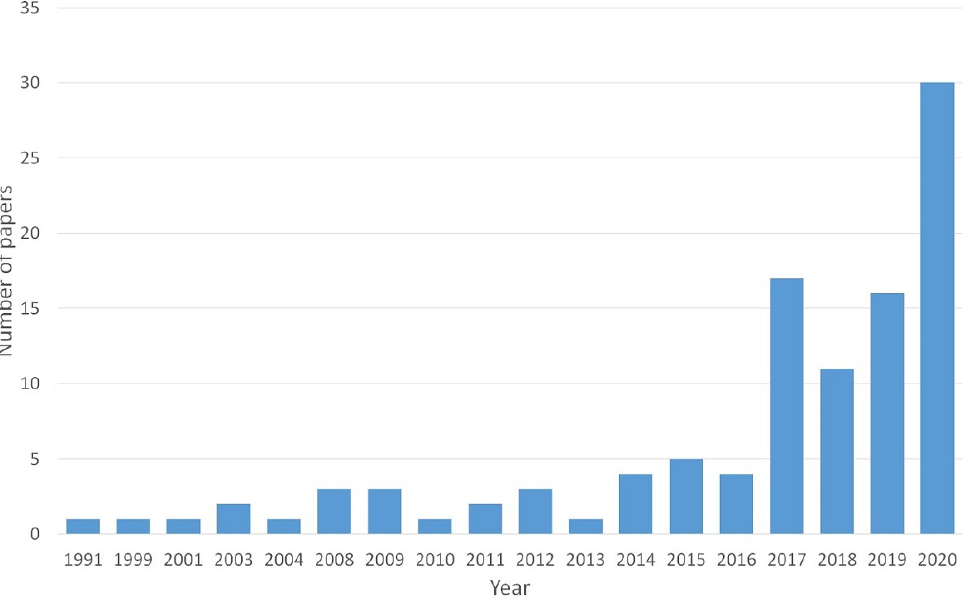
Figure 3. Yearly distribution of studies on